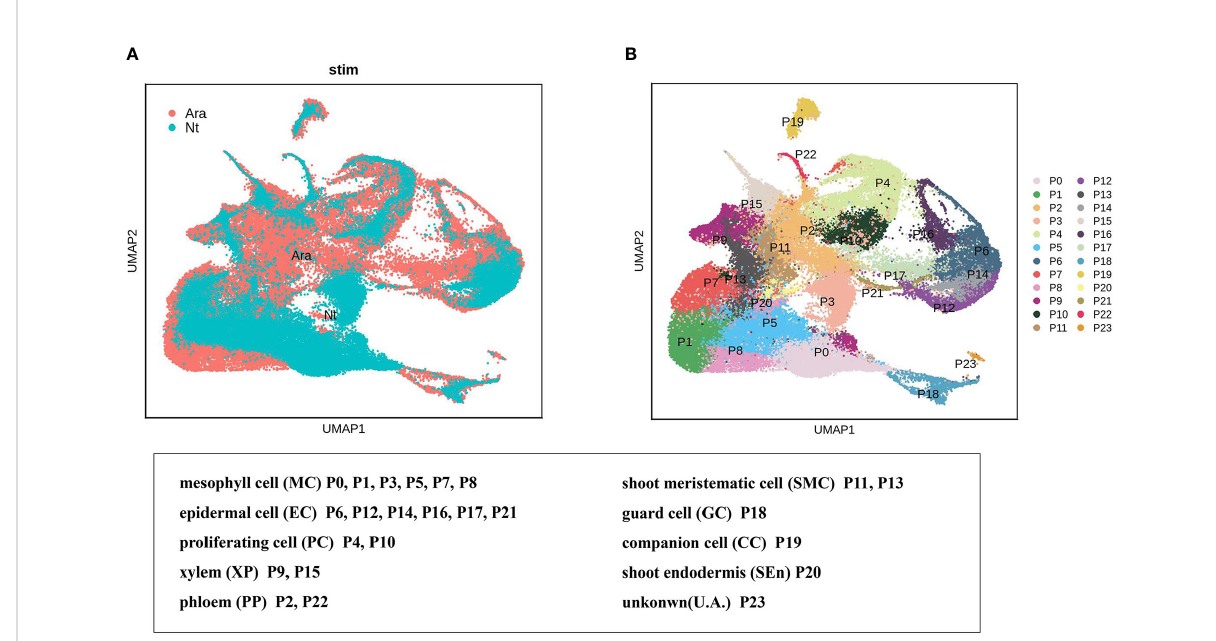
FIGURE 5 Comparison of N. tenuifolia leaf and Arabidopsis shoot single-cell resolution. (A) The overlapped UMAP plot of clusters of N. tenuifolia leaf and Arabidopsis cells. (B) UMAP plot showing 24 cell clusters of N. tenuifolia leaf and Arabidopsis